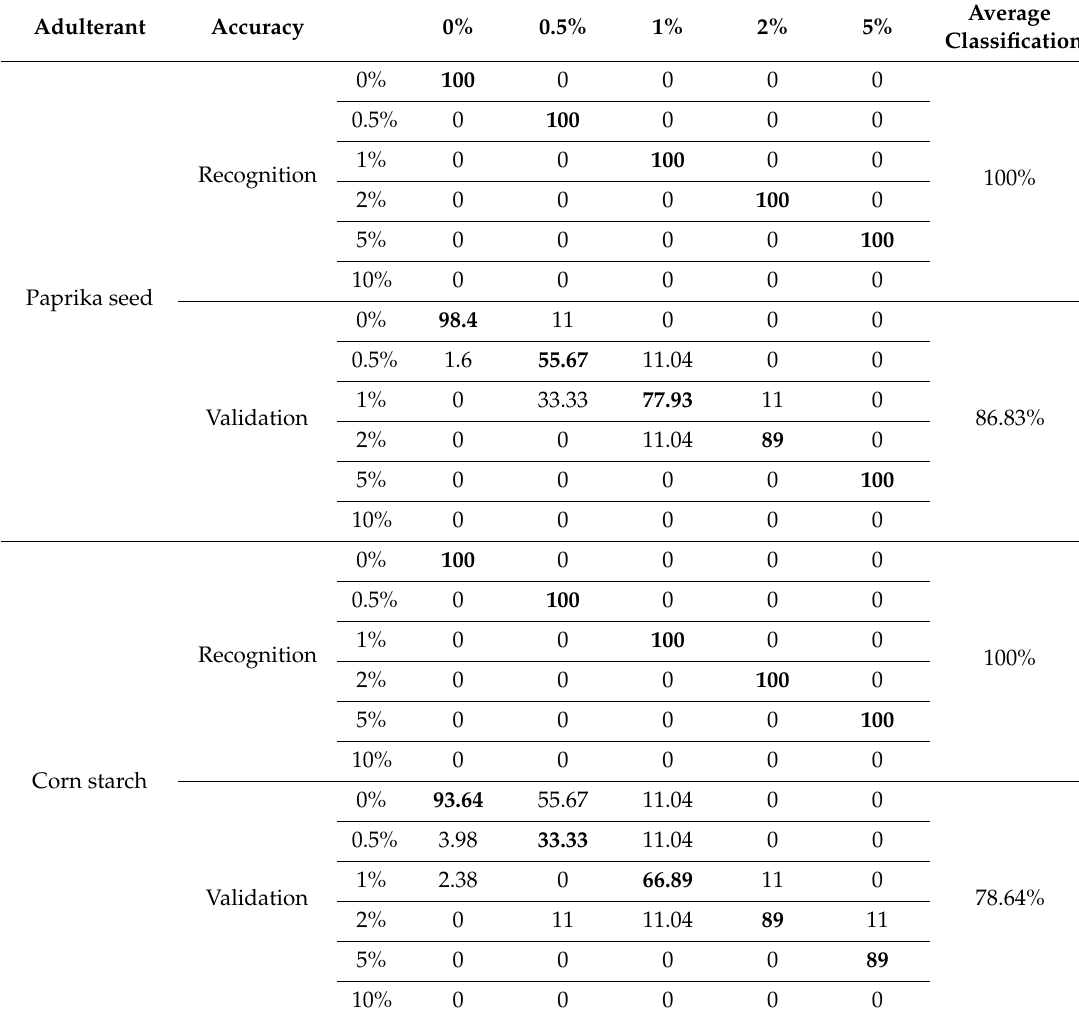
Table 5. LDA classification after three-fold cross-validation and SG and MSC pretreated NIRS spectra when the adulterant concentration was used as class variable on paprika seed and starch dataset. Adulterant Accuracy 0%